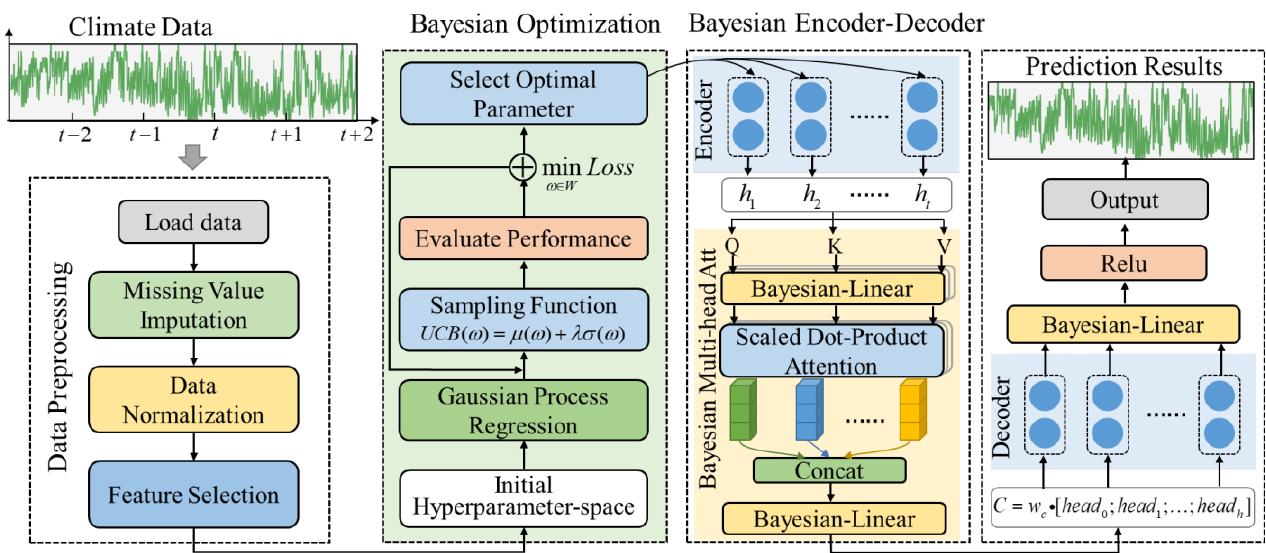
Figure 1. The overall framework of the BMAE-Net.